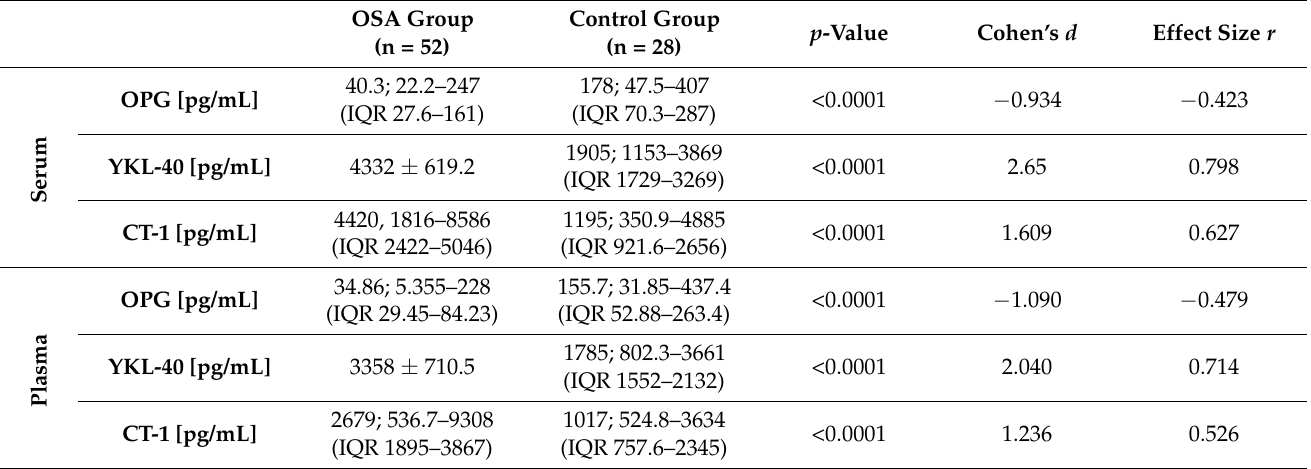
Table 2. The concentrations of OPG, YKL-40, and CT-1 in the serum and plasma. OSA Group Control Group p -Value Cohen’s d Effect Size (n = 52) (n = 28)